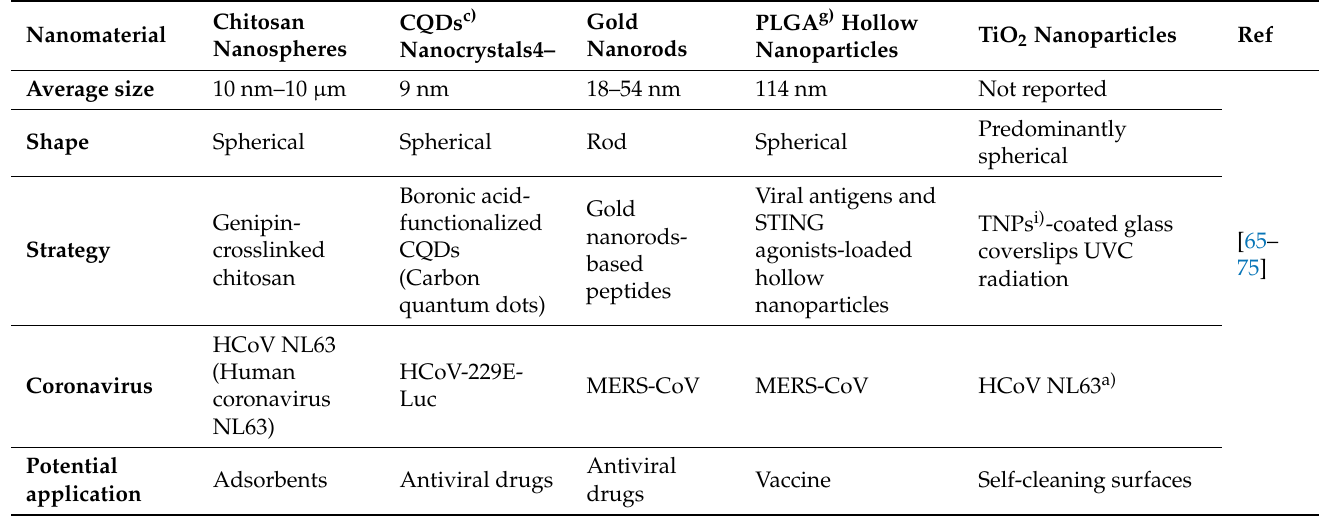
Table 4. List of Nanomaterial’s approach against coronavirus.